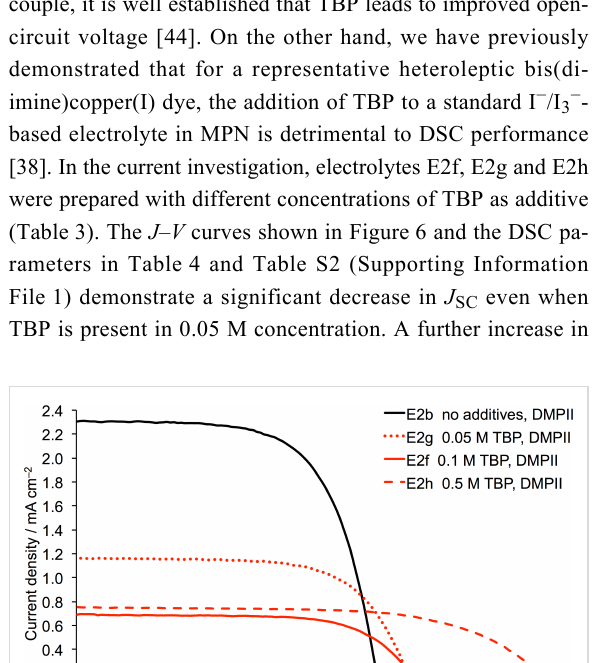
We now turn to the effects of using TBP as an additive, while retaining DMPII as the ionic liquid in the electrolyte. For couple, it is well established that TBP leads to improved open- circuit voltage [44]. On the other hand, we have